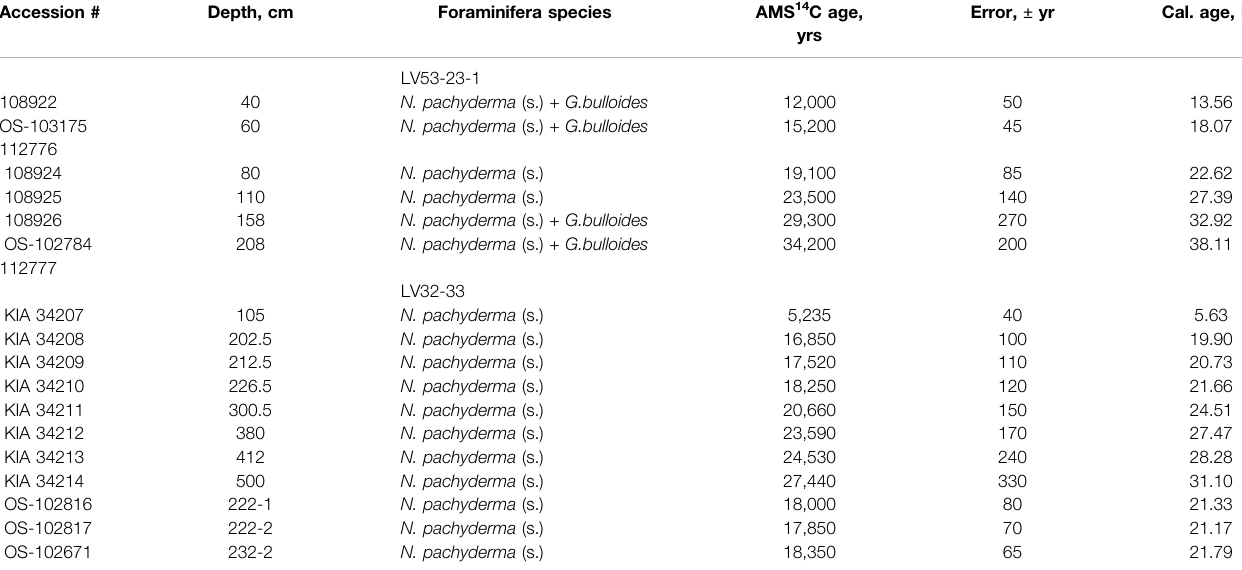
TABLE 1 | AMS 14 C data on monospecies planktic foraminifera N. pachyderma (s.) for core LV53-23-1 (Gorbarenko et al., 2015) and LV32-33(Gorbarenko et al., 2014). All measured 14 C age data were corrected for the Japan Sea surface water reservoir age of 400 years (Yokoyama et al., 2007). All radiocarbon ages were converted